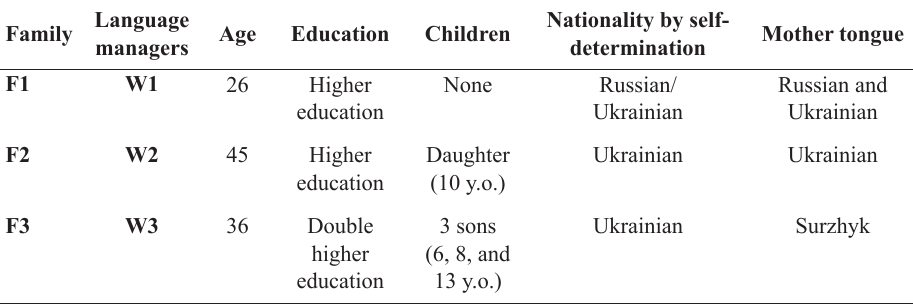
Table 1. General information of language managers of Sunday School Nadija Language Family